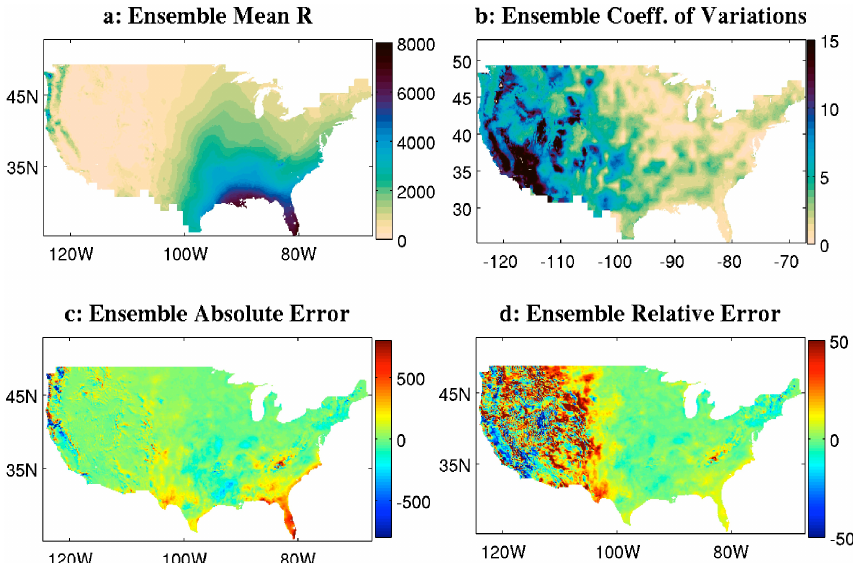
Figure 8. Evaluation of climate model estimates of R . Method 2 (the method of Fig. 5). (a) Ensemble mean erosivity. (b) Intra-ensemble stan- dard deviation, divided by the ensemble mean erosivity (%). (c) Absolute error of the ensemble mean, compared to the target R . (d) Relative error of the ensemble mean.